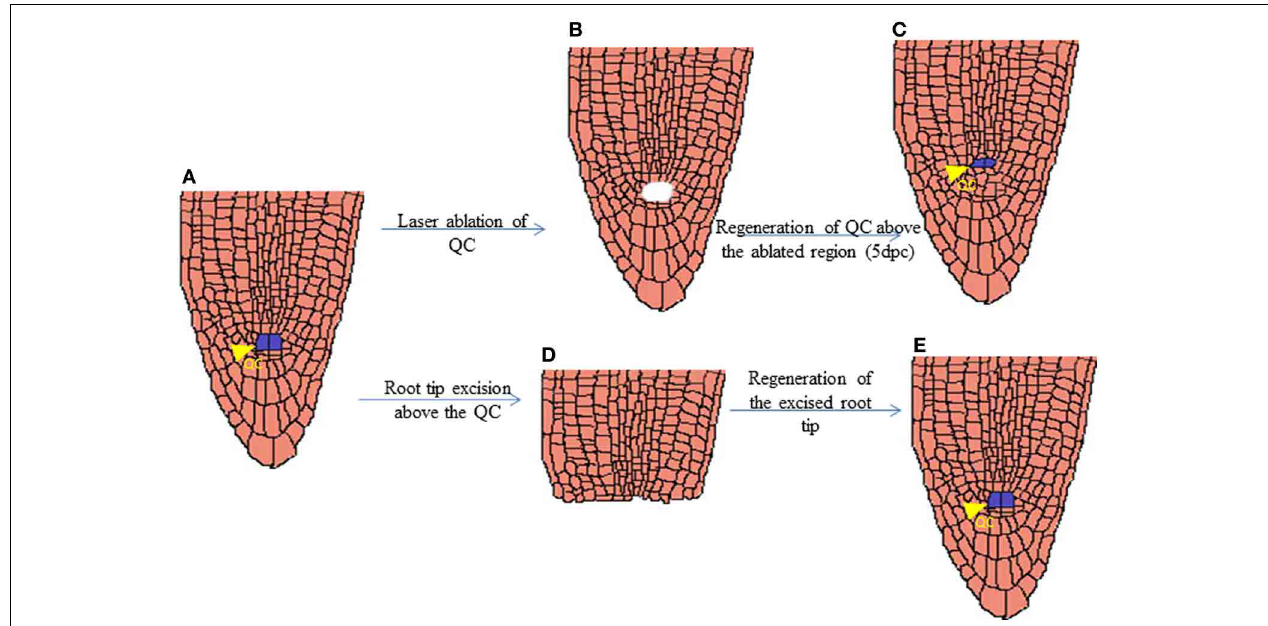
FIGURE 3 | Schematic representation of regenerated QC after laser ablation and root tip excision. Arabidopsis root tip with Quiescence cells (QC) marked in Blue (A) . Root tip after Laser Ablation of QC cells (B) .